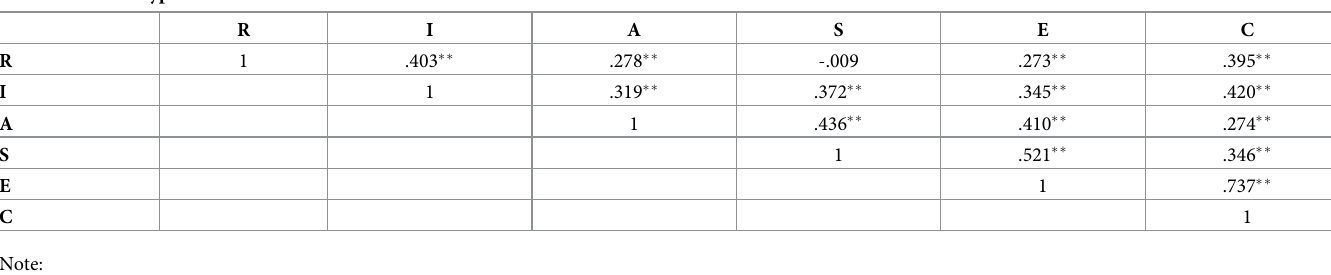
Table 2. Interest type intercorrelations.